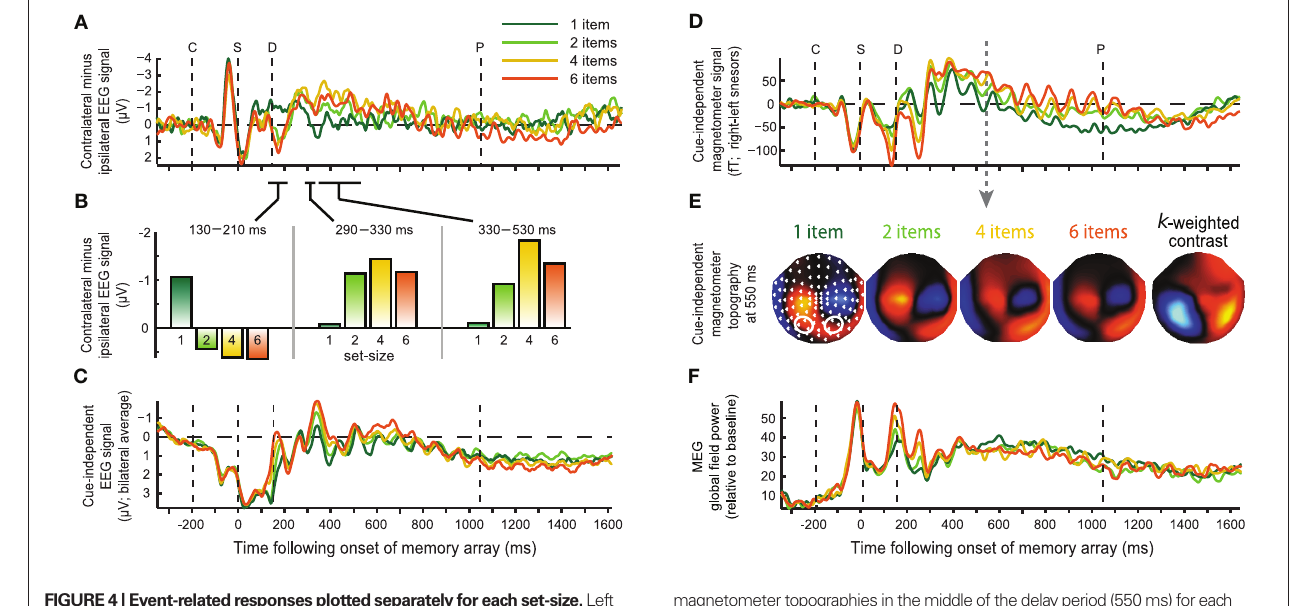
Figure 4 | event-related responses plotted separately for each set-size. Left column: EEG signal averaged over electrodes PO3, PO4, O1, O2, for the eCDA time-course (A) , eCDA averaged across successive time windows (B) , and eBDA time-course (C) . Right column: Magnetometer signal reflecting mBDA time-course (D) at selected sensors marked below (right sensors–left sensors); (e)